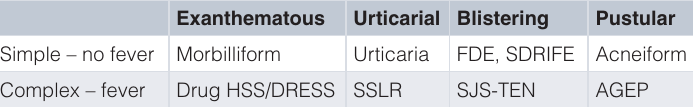
Table 2. Morphology and severity